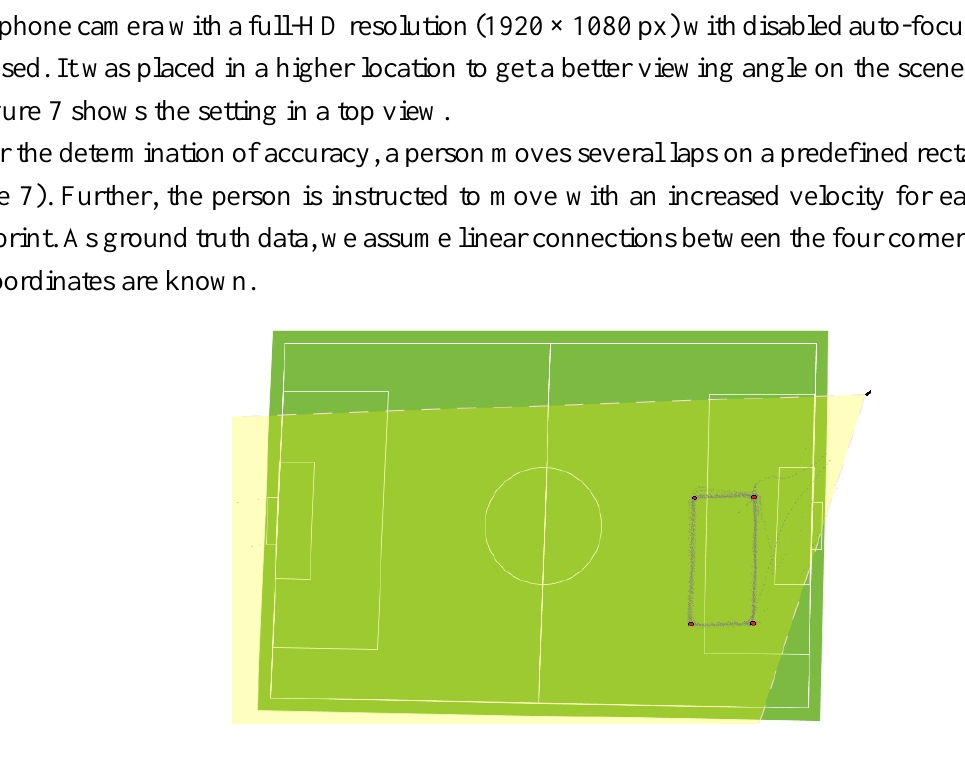
Figure 7. Overview of the setup for the first and second experiment: The four edge points waypoints for the first experiment are marked in red. The gray traces are the locations of the detections of the